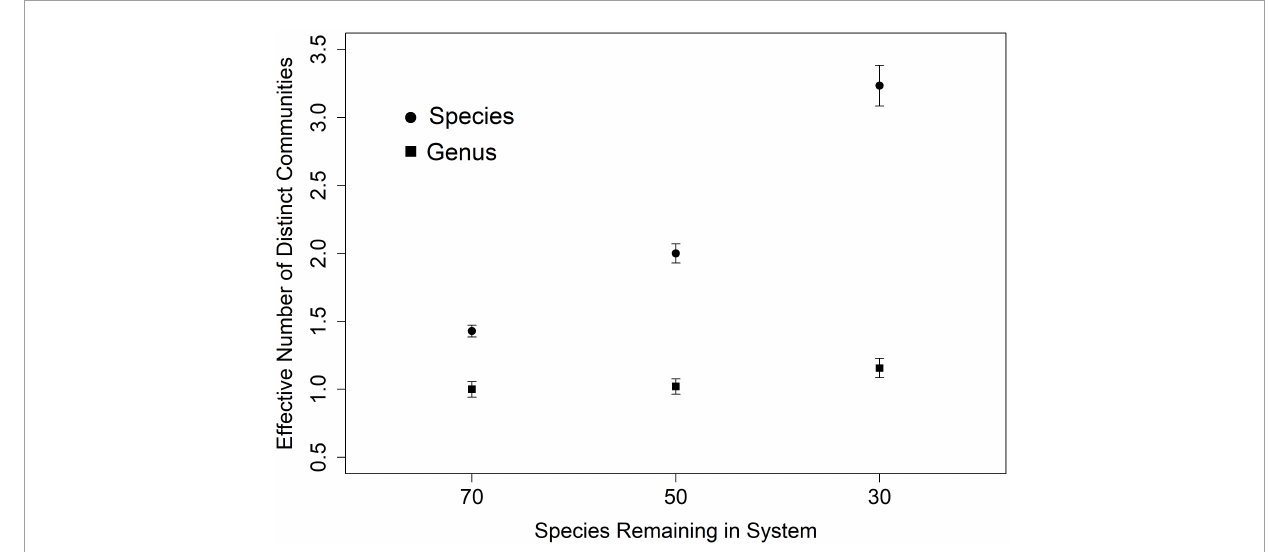
FIGURE5 Species are not equitably distributed among genera in a survey of aquatic insects in 17 national parks in the southeastern United States (Robinson et al., 2016). The magnitude of this effect varies among insect orders.